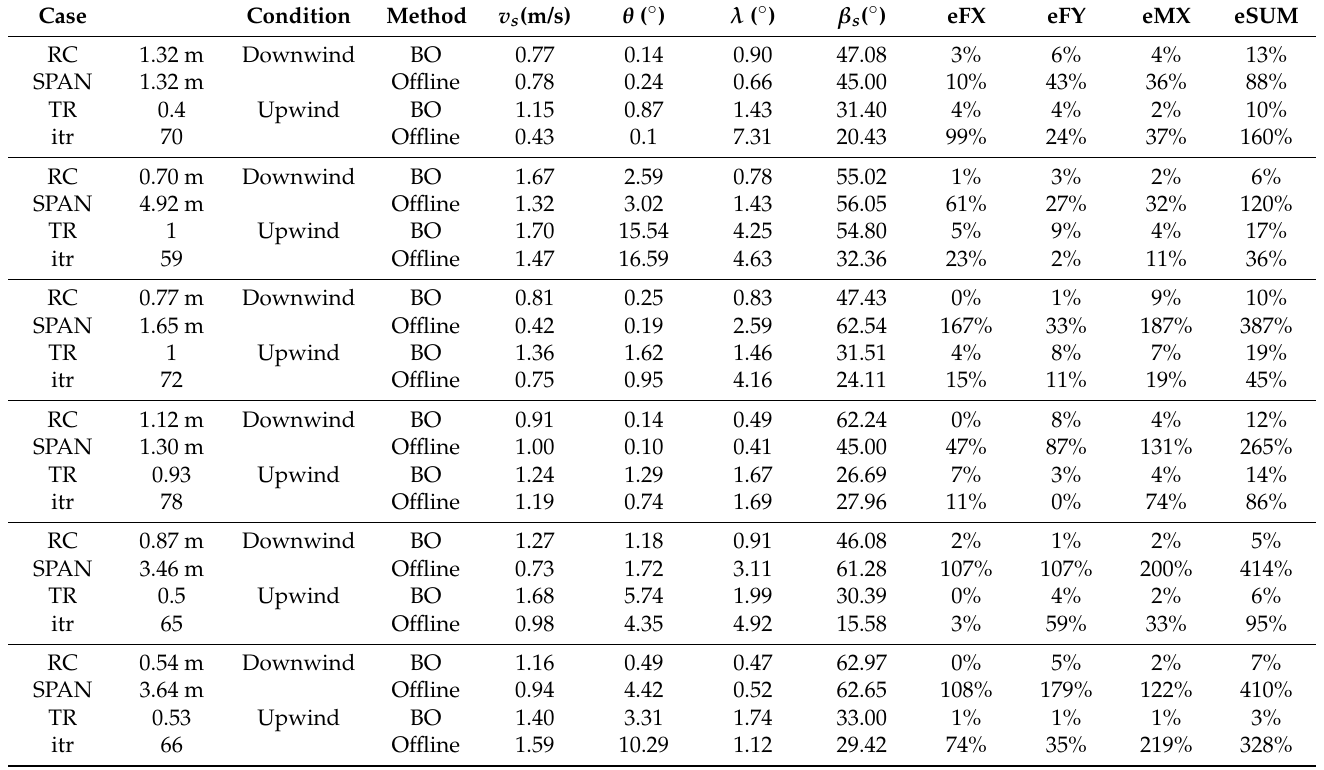
Table 2. Comparison of equilibrium states solved by offline methods and